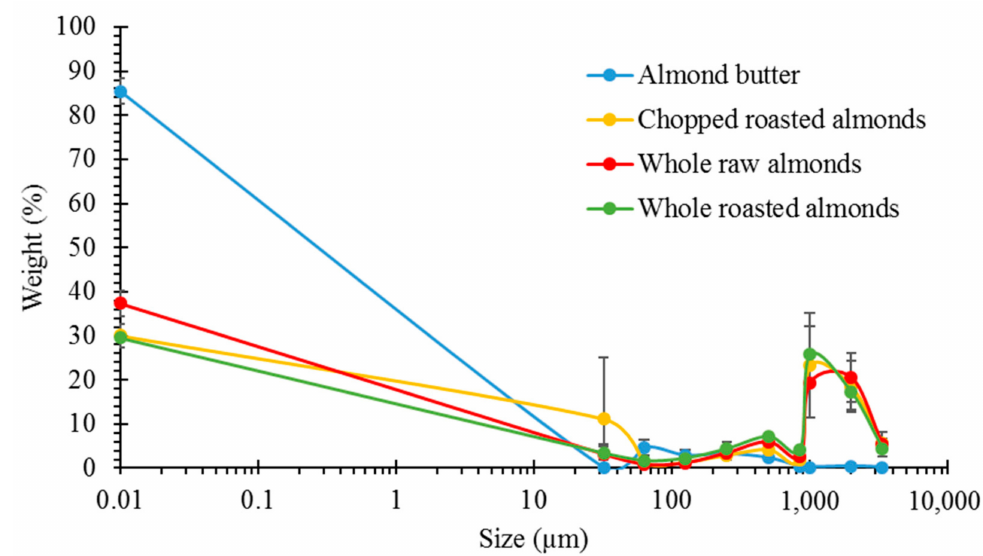
Figure 1. Particle size distributions by mechanical sieving of almond boluses ( n = 2). The weight % of all material recovered in the sieve base (<32 µ m) is given at size = 0.01 µ m.